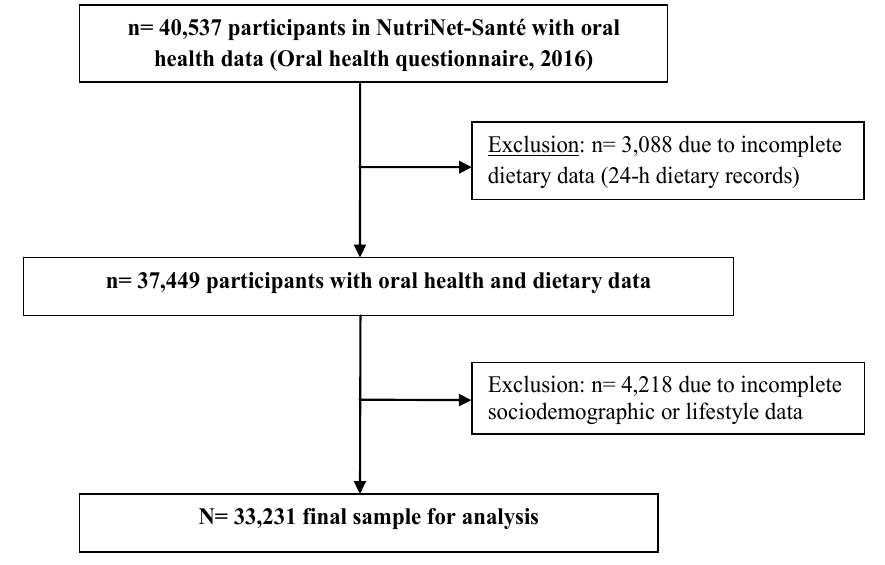
Figure 1. Participant selection flowchart.